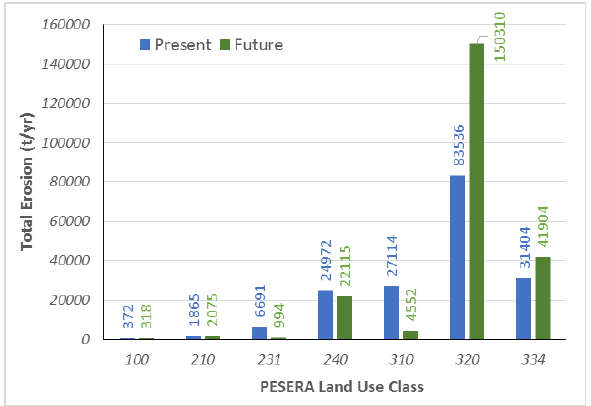
Figure 6. Total erosion of the PESERA land use classes of the Egribuk Subcatchment estimated using the PESERA model. Monthly soil loss